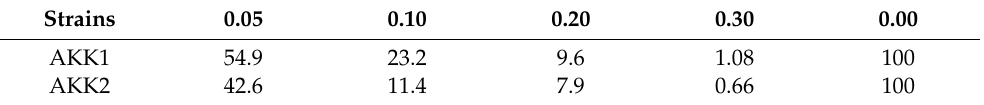
Table 3. The survival rate of strains under different bile salt concentration (%).